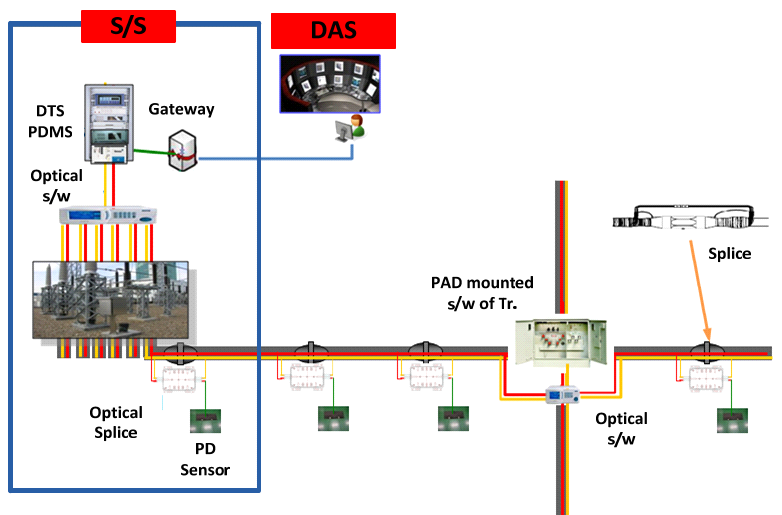
Figure 2. Diagram of the intelligent cable monitoring system